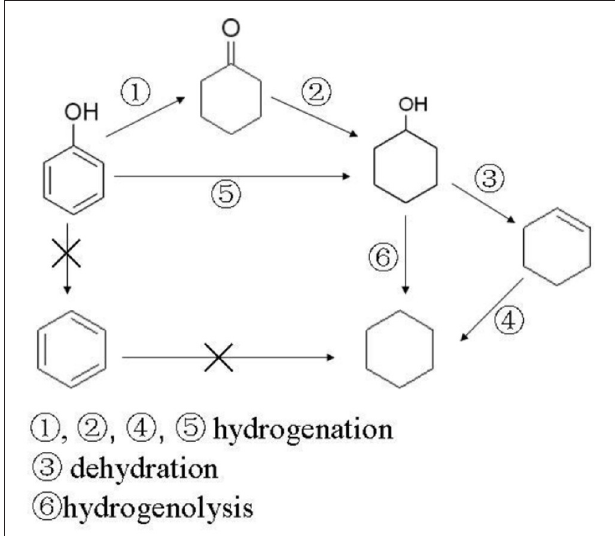
SCHEME 1 | Proposed reaction mechanism for HDO of